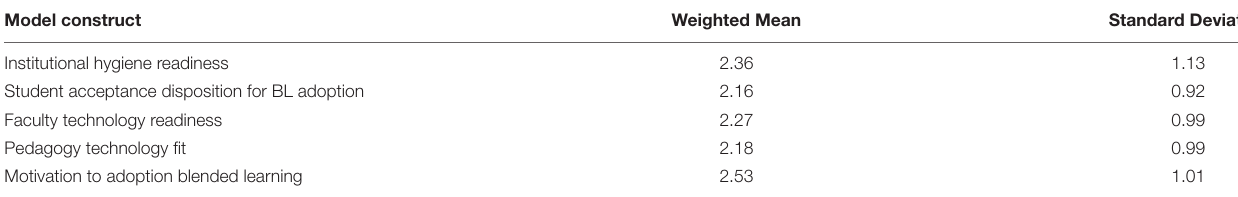
TABLE 5 | Descriptive statistics of model construct.